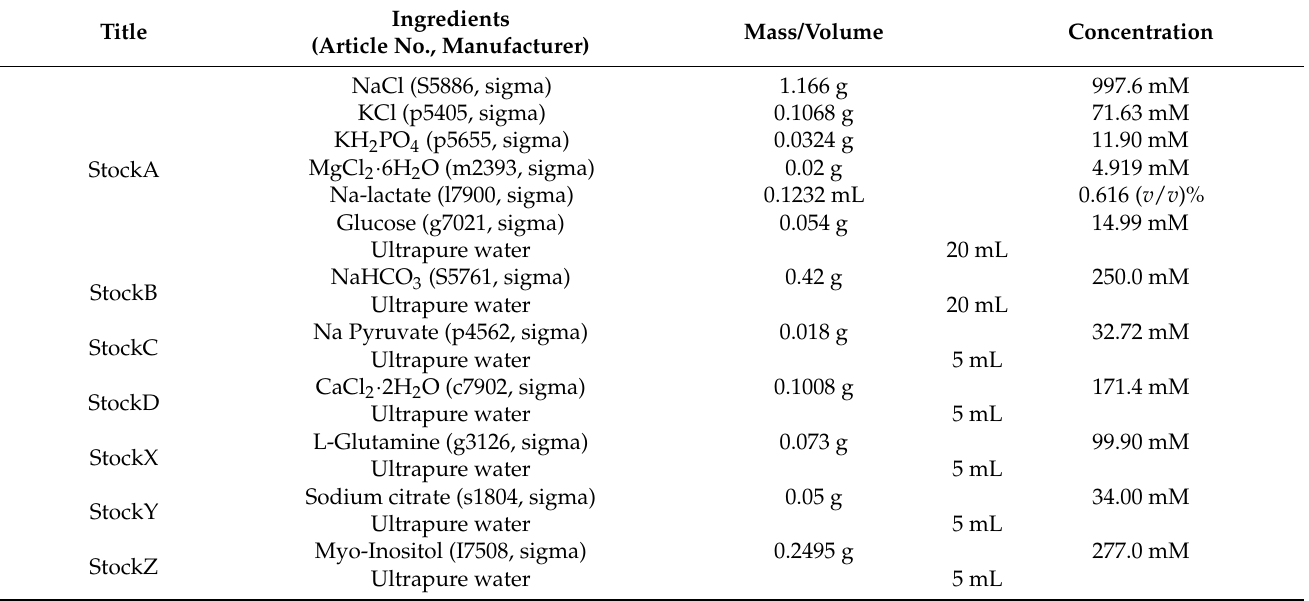
Table 2. Base Liquid ingredient formulation standard.